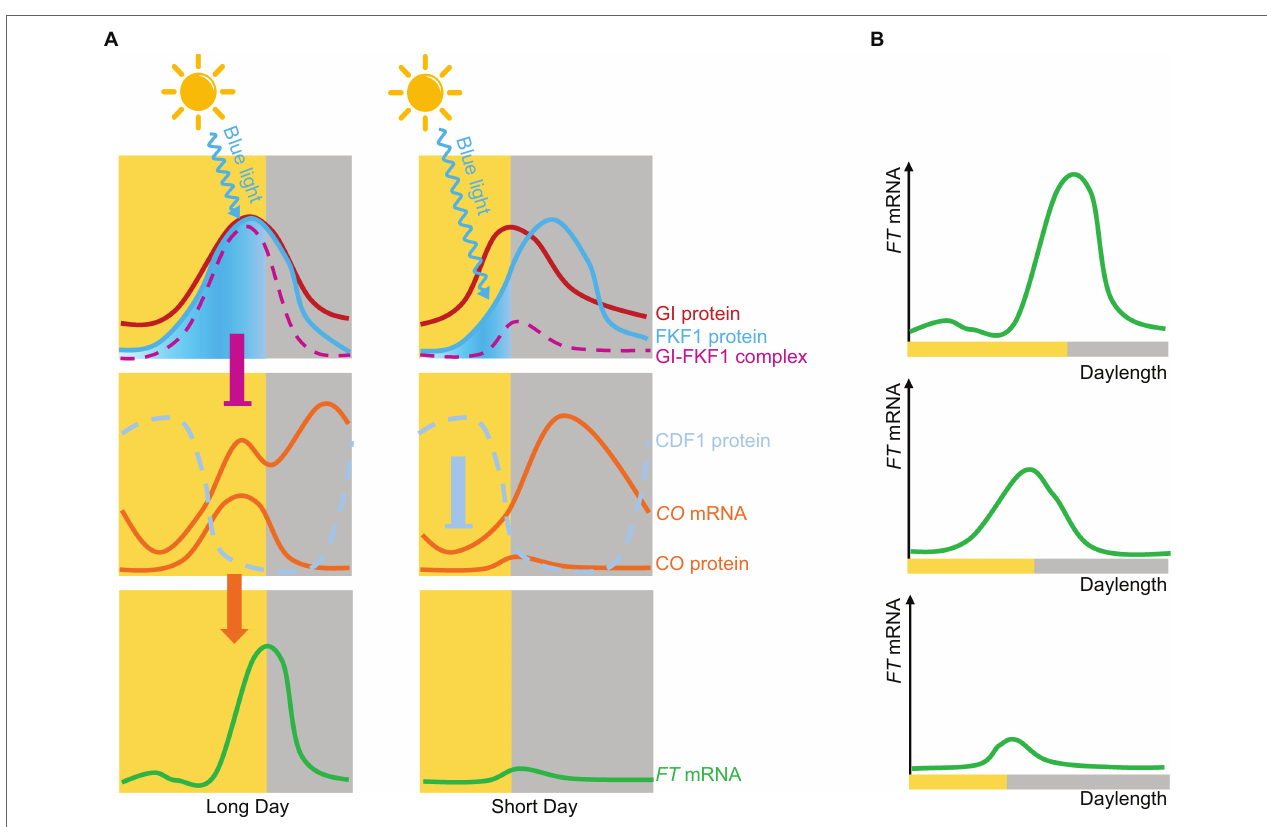
FIGURE 2 | Internal and external coincidence models of photoperiodic flowering in Arabidopsis. (A) Molecular mechanism of Arabidopsis flowering. Under long- day conditions, the expression peaks of GI and FLAVIN-BINDING, KELCH REPEAT, F-BOX 1 ( FKF1 ) are the same. FKF1 is activated by blue light and forms a complex with GI; this complex represses the expression of CYCLING DOF FACTOR 1 ( CDF1 ), thereby promoting CO expression and further activating the expression of FT. Under short-day conditions, the expression peaks of GI and FKF1 are out of synchrony, and only very low levels of the GI-FKF1 complex are formed, so that CDF1 accumulates and inhibits CO expression of CO , which in turns reduces FT expression. (B) FT mRNA gradually increases with longer